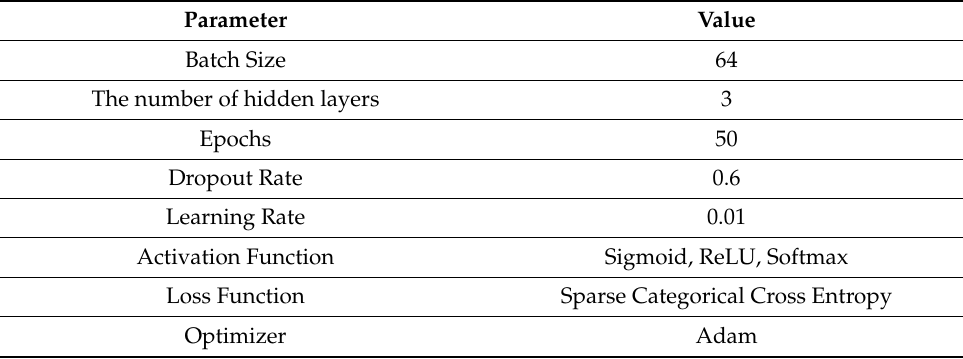
Table 3. Hyperparameters of used deep learning